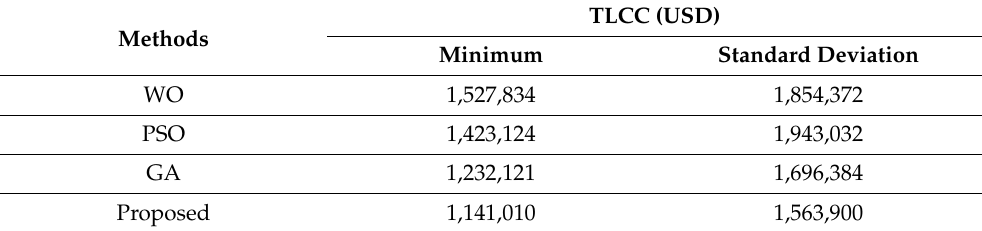
Table 2. Comparison of TLCC for wind/battery/ROD.